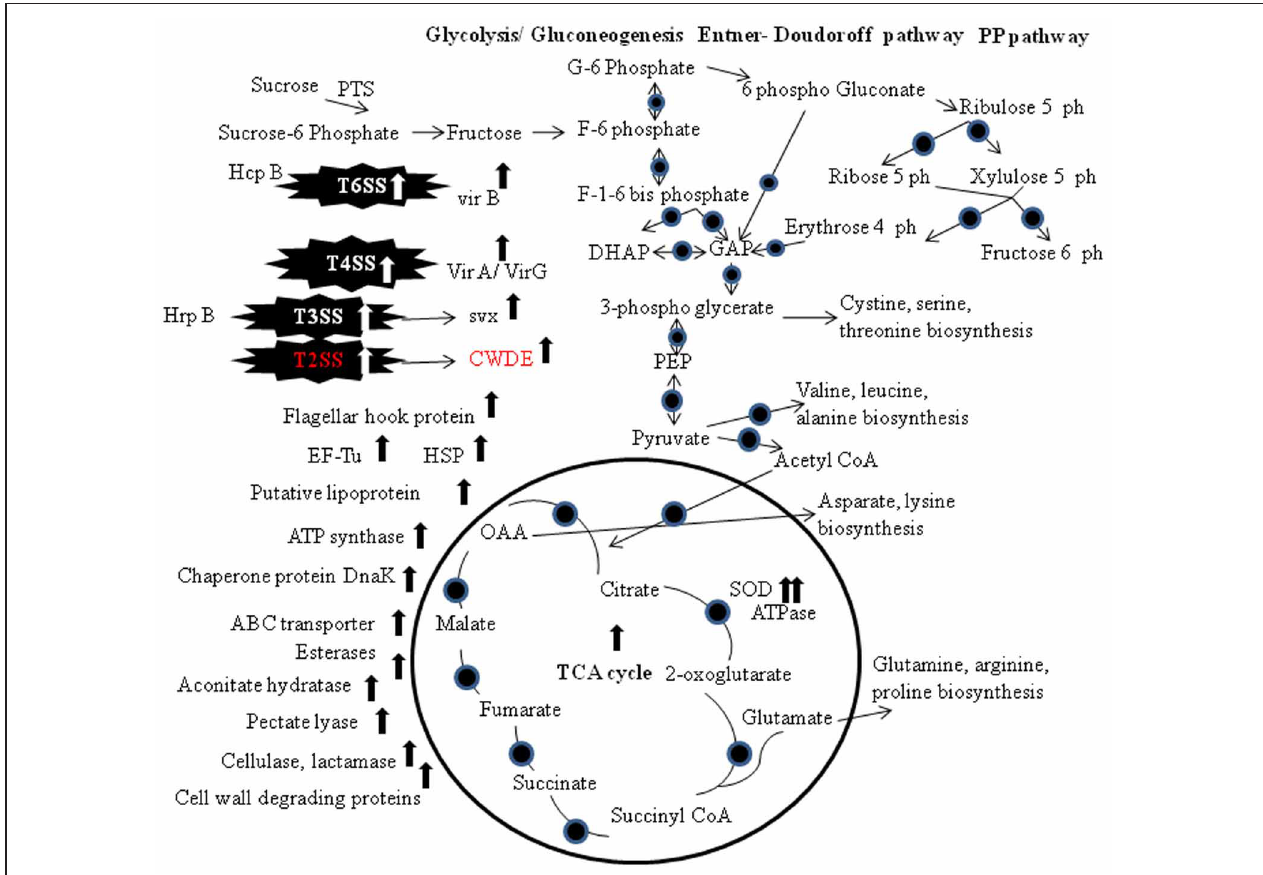
FIGURE 2 | Biochemical pathways of the pathogen secretion system and proteins expression. The TCA cycle, gluconeogenesis/glycolysis, Entner–Doudoroff pathway and the Pentose Phosphate pathway are shown. Circles indicate proteins that have been detected at the transcriptomics and/or proteomics level. Abbreviations: PP, Pentose Phosphate; PTS, phosphoenol pyruvate-carbohydrate